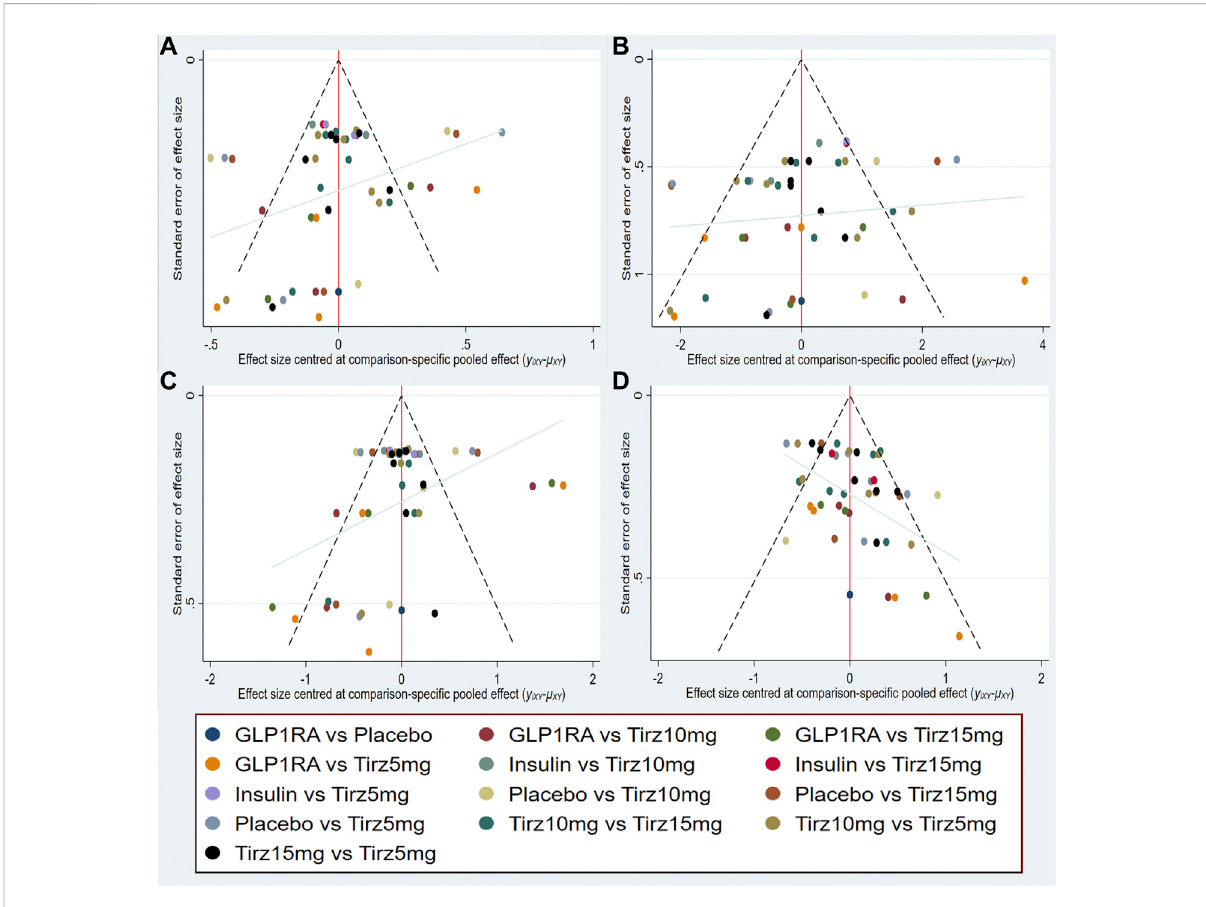
FIGURE 5 Comparison-adjusted funnel plot for (A) HbA1c; (B) Body weight; (C) FSG; (D) gastrointestinal adverse